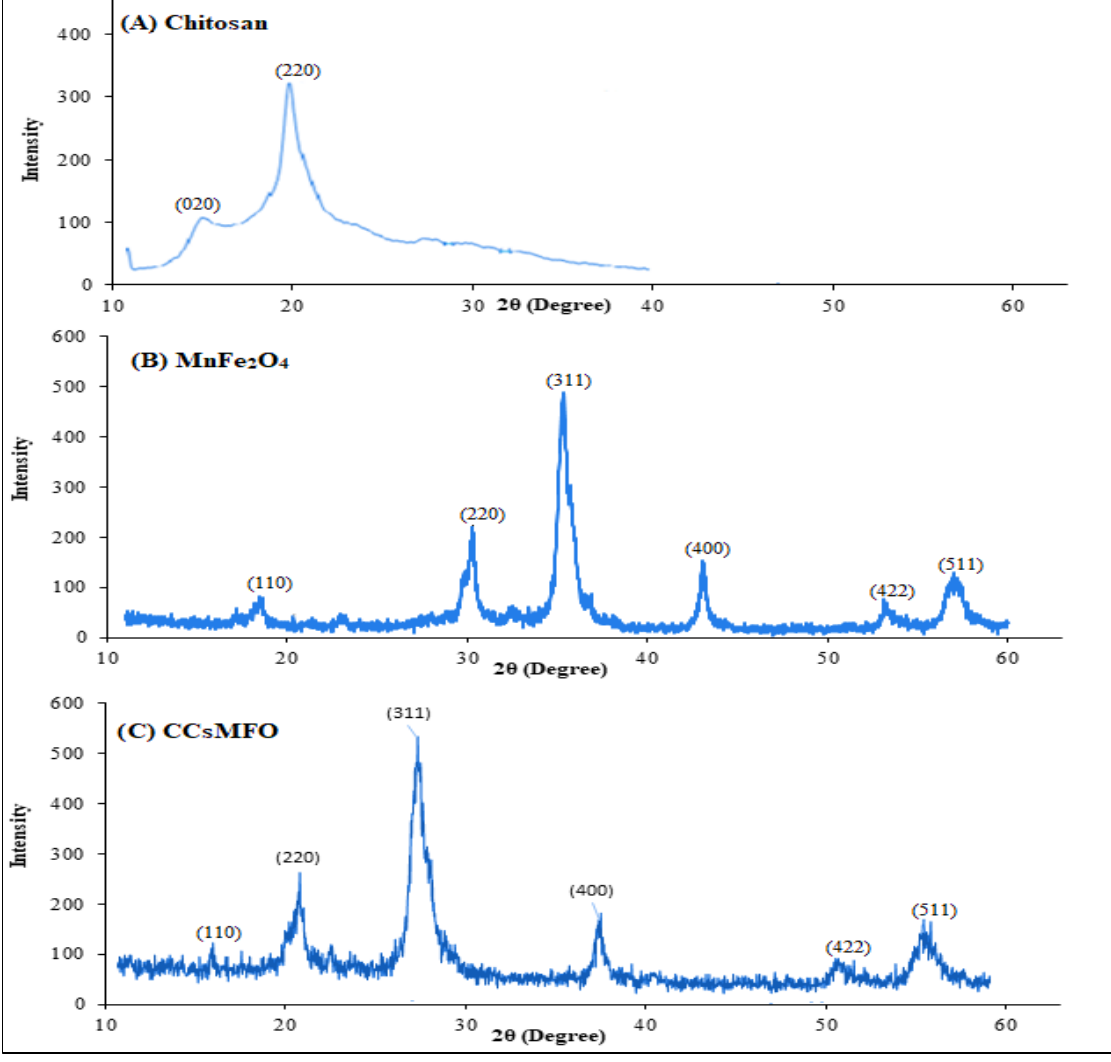
Figure 3. XRD spectrum for ( A ) MnFe 2 O 4 NPs, ( B ) chitosan, and ( C ) CCsMFO nanocomposite.